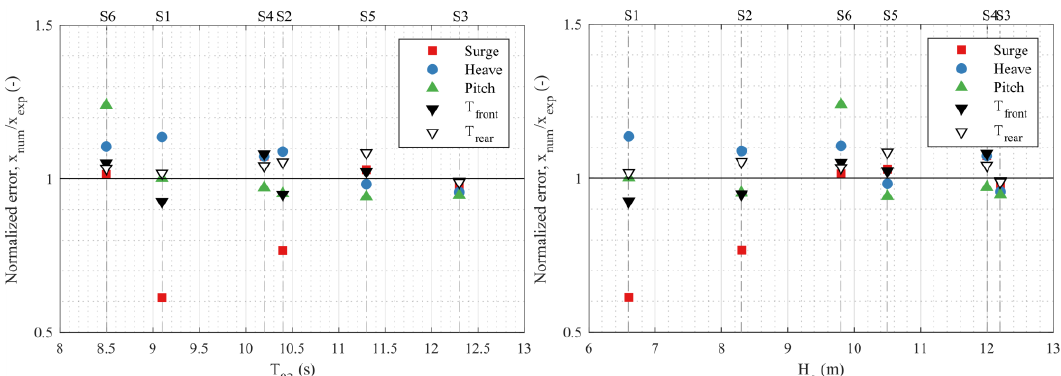
Figure 20. Normalized error between numerical model and experimental results as function of wave period ( left ) and wave height ( right ).